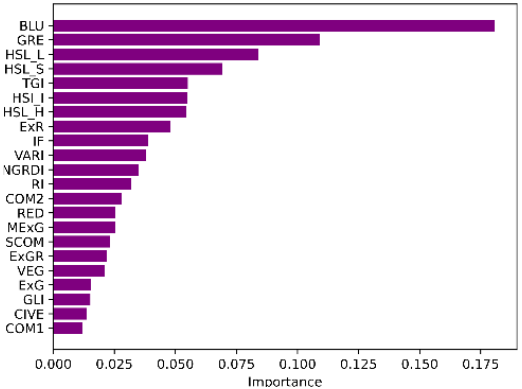
Figure 4. Random forest for feature importance on a regression